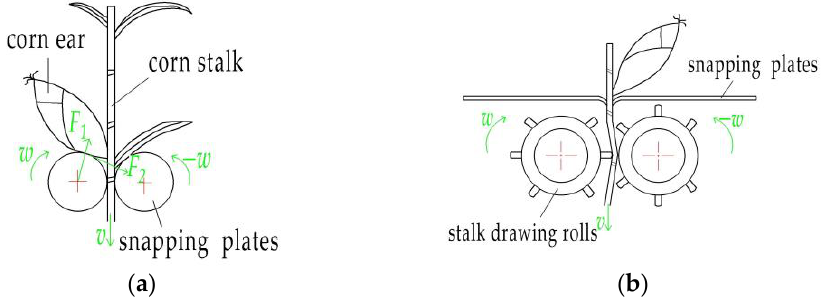
Figure 1. Principle of picking corn ears. ( a ) The type of snapping rollers. ( b ) The combination type of picking plate and stalk pulling rollers.